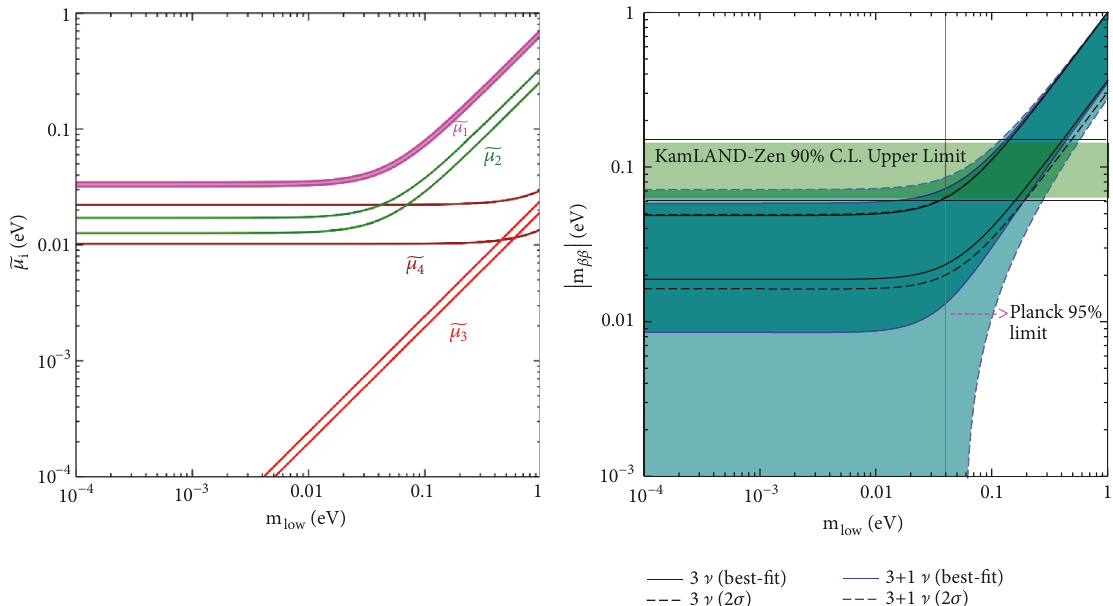
Figure 2: Left panel shows the four partial mass contribution to |𝑚 𝛽𝛽 | in (12) as function of the lightest mass 𝑚 𝑙𝑜𝑤 for 3𝜎 allowed intervals in the case of 3+1 ] mixing with Inverted Ordering. Right pannel shows the allowed ranges in |𝑚 𝛽𝛽 | - 𝑚 𝑙𝑜𝑤 parameter space, both in the standard three-neutrino picture (unfilled band space) and with one sterile neutrino (filled band space) for the 3+1 case as defined by (14).